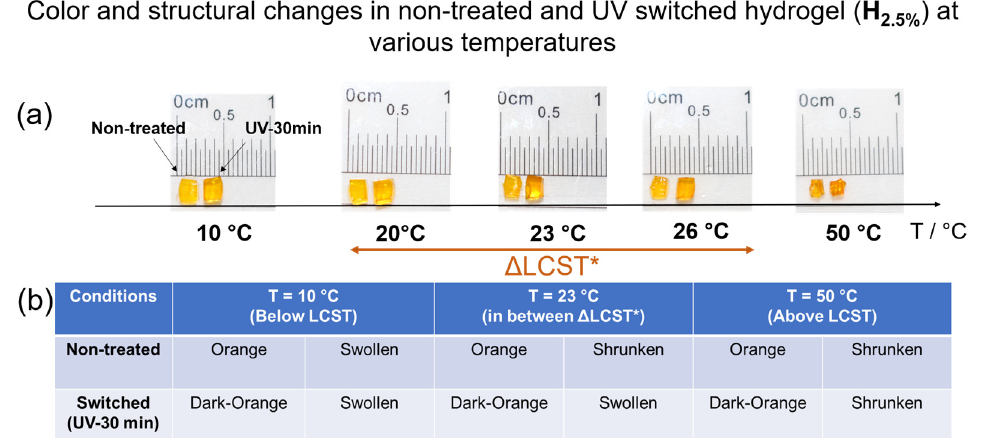
Figure 6. Photographic images of hydrogel ( H 2.5% ) in non-treated and UV-switched state at various temperatures: ( a ) 10 °C (below LCST), the bistable temperature range 20 °C to 26 °C with a central temperature 23 °C and 50 °C (above LCST); ( b ) tabulated information on the color and structural change in the hydrogel at the forementioned temperatures in °C.